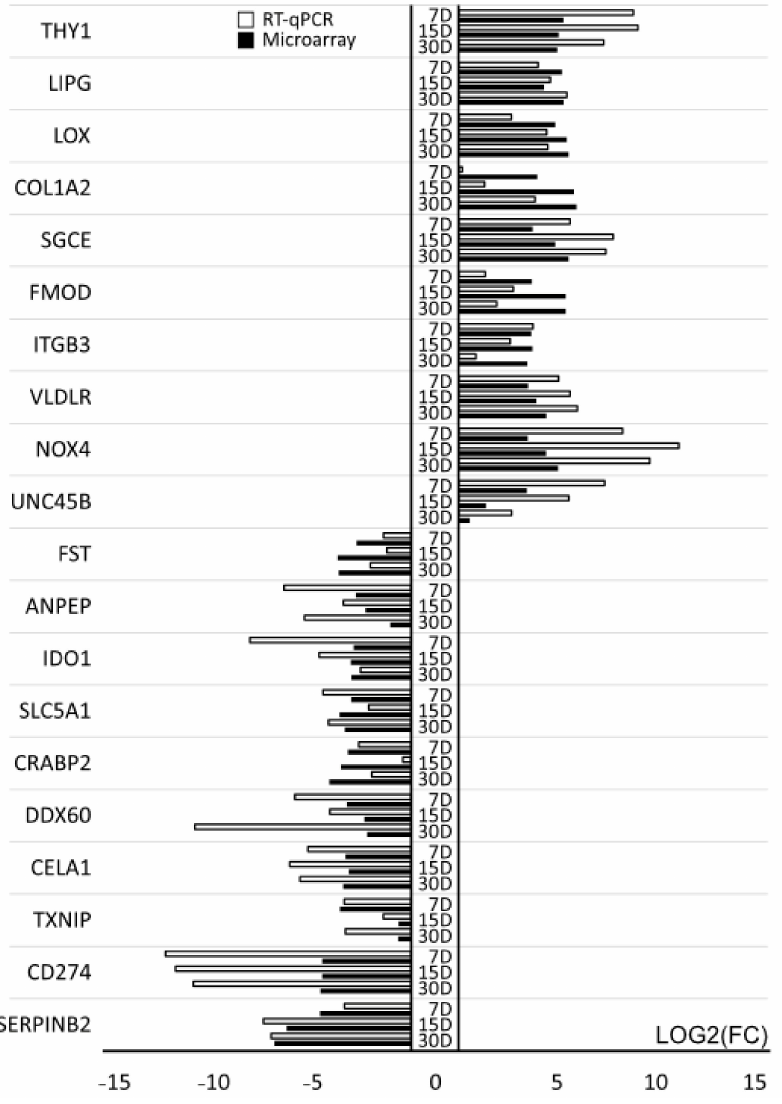
Figure 8. RT-qPCR quantitative validation of microarray results presented in a form of a bar